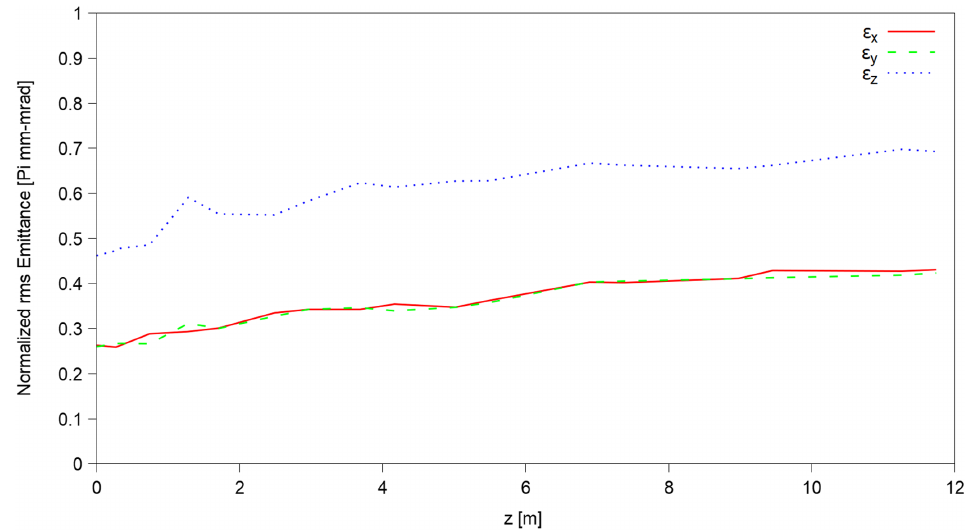
FIG. 9. Emittance evolutions along the 6 MW DTL (red, x plane; green, y plane; blue, longitudinal